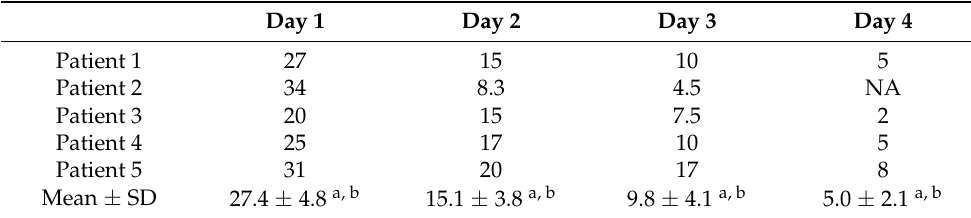
Table 1. Daily TAC levels (ng/mL). Comparison using t